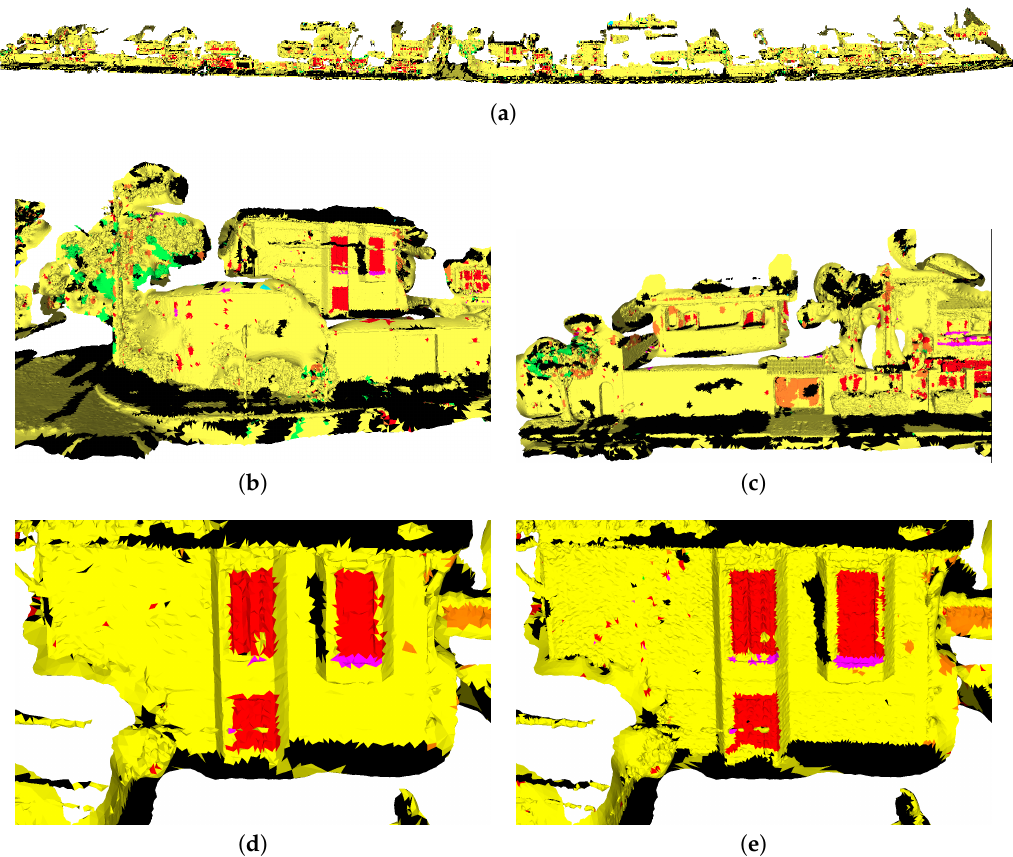
Figure 14. 3D-labeled model of SJC. ( a ) Wide view of the street; ( b ) same view of Figure 13a, after the 3D-labeling procedure; ( c ) region with spurious labeling; most of the 3D street model was spurious due to the image segmentation quality; ( d ) close look of features’ details reconstructed by the sparse point cloud; ( e ) example of the same area using a dense point cloud reconstruction.